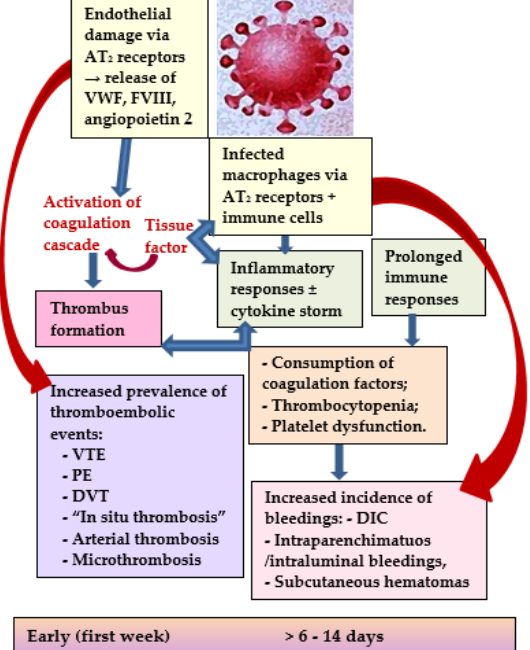
Figure 1. Schematic presentation of pathophysiological pathways responsible for the occurrence of thromboembolic and bleeding complications in COVID-19. Legend: AT2-angiotensin-II; VWF-von Willebrand factor; FVIII-factor VIII; VTE-venous thromboembolism; PE-pulmonary embolism; DVT-deep vein thrombosis; DIC-disseminated intravascular